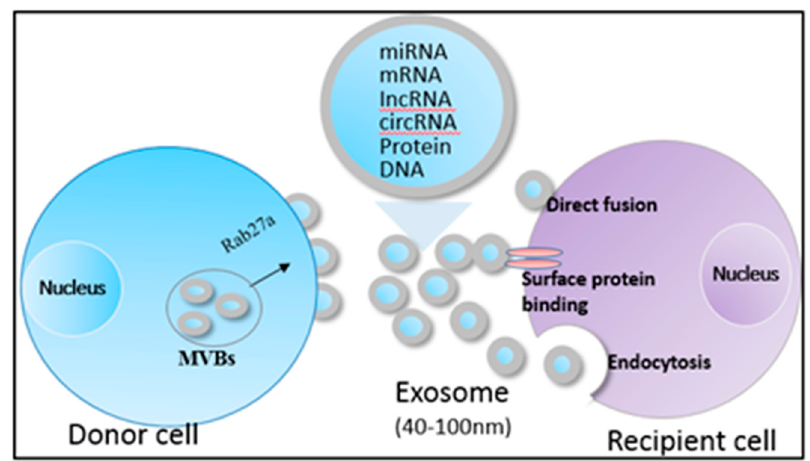
Figure 1. Biogenesis and contents of HCC-exosomes. Exosomes harbor proteins, mRNAs, miRNAs, lncRNAs, circRNAs, and DNAs, and transfer them to the recipient cells via direct fusion, binding with surface proteins and endocytosis.